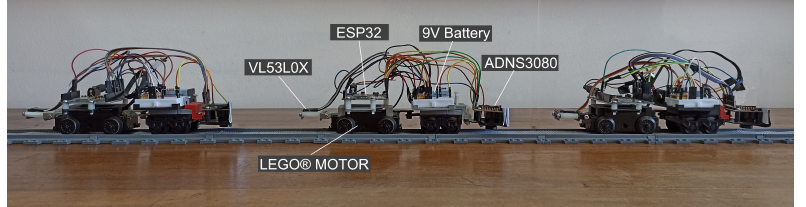
Figure 6. Some of the PL-TOON agents used in the experiments. Each vehicle is about 20 cm long and has the components labeled in the